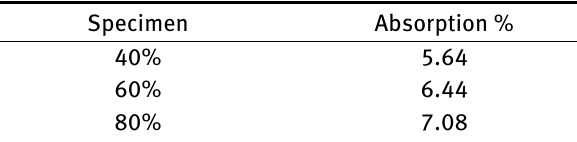
Table 22: Flexural strength of geopolymer mortar reinforced with 1%